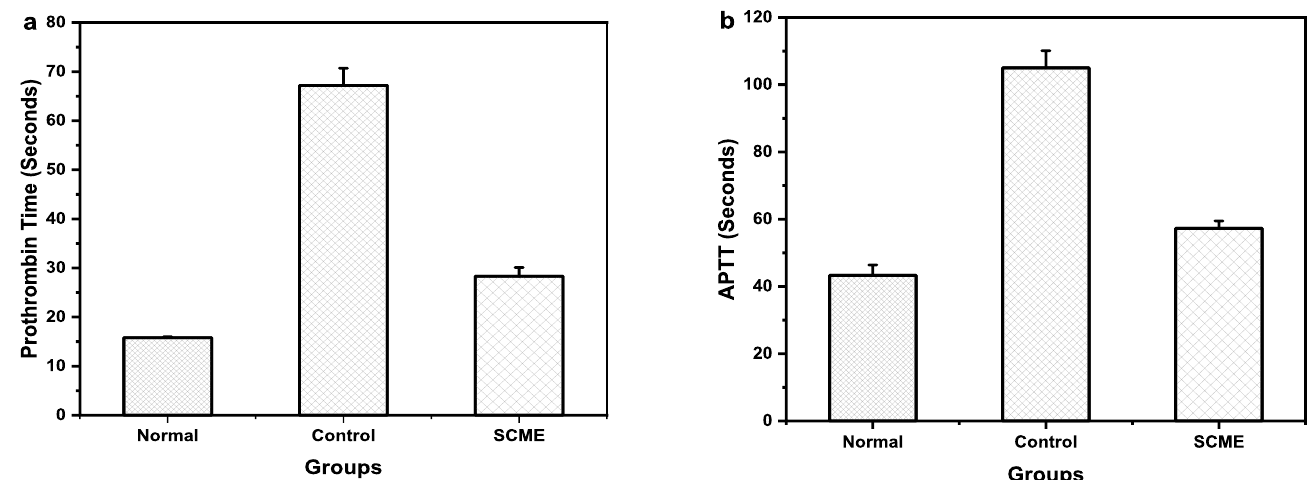
Fig 3. Anticoagulant activity. (a) Clot lysis by Prothrombin time (PT) assay in vitro , clotting time of S . cumini leaves extract was higher than normal but lower than control. (b) Activated partial thromboplastin time (APTT) assay in vitro . All readings are taken in triplicates and values are expressed as Mean ± SEM.